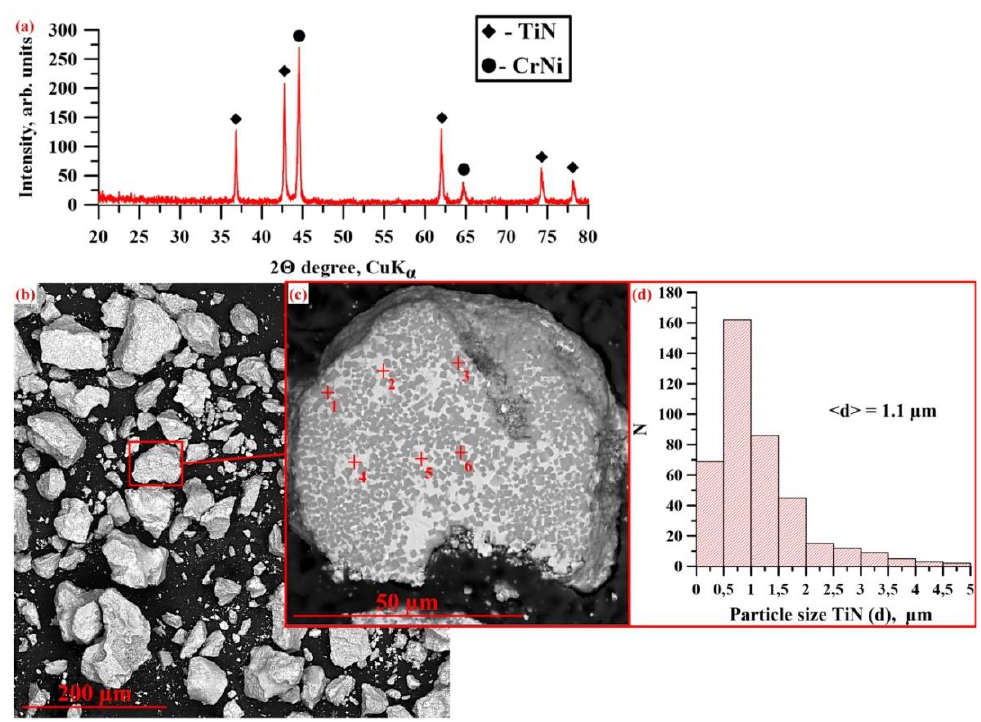
Figure 4. X-ray diffraction pattern of SHS powders obtained from a CrN + TiNi mixture ( a ), SEM images of these powders ( b , c ), and a histogram of TiN particle size distribution ( d ). Table 2. The results of X-ray diffraction analysis of SHS powders obtained from a CrN + TiNi mixture.